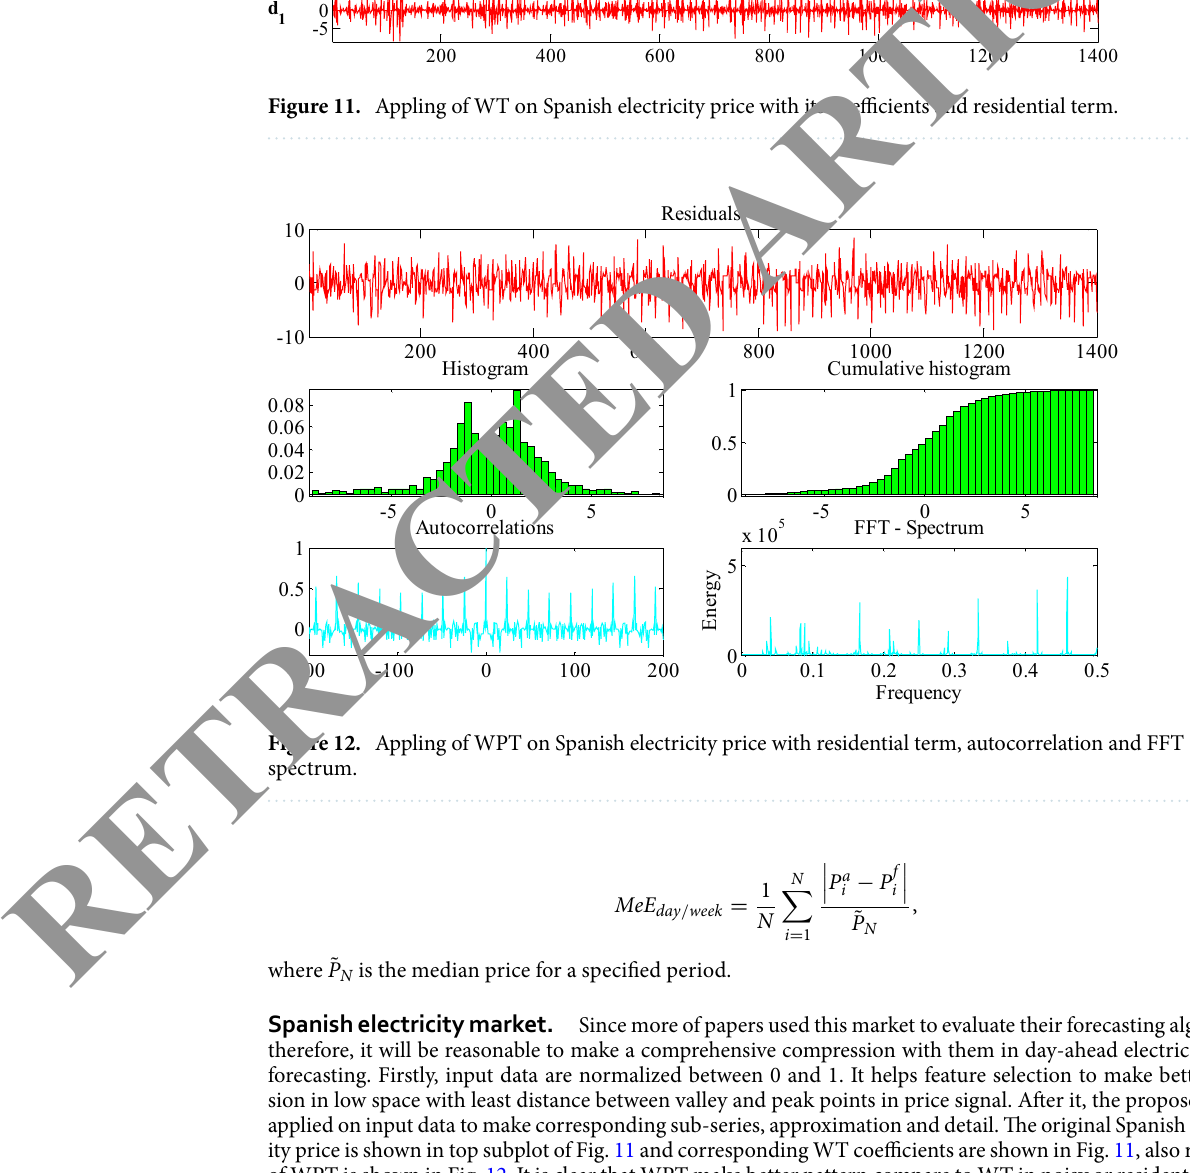
Figure 11. Appling of WT on Spanish electricity price with its coefficients and residential term.